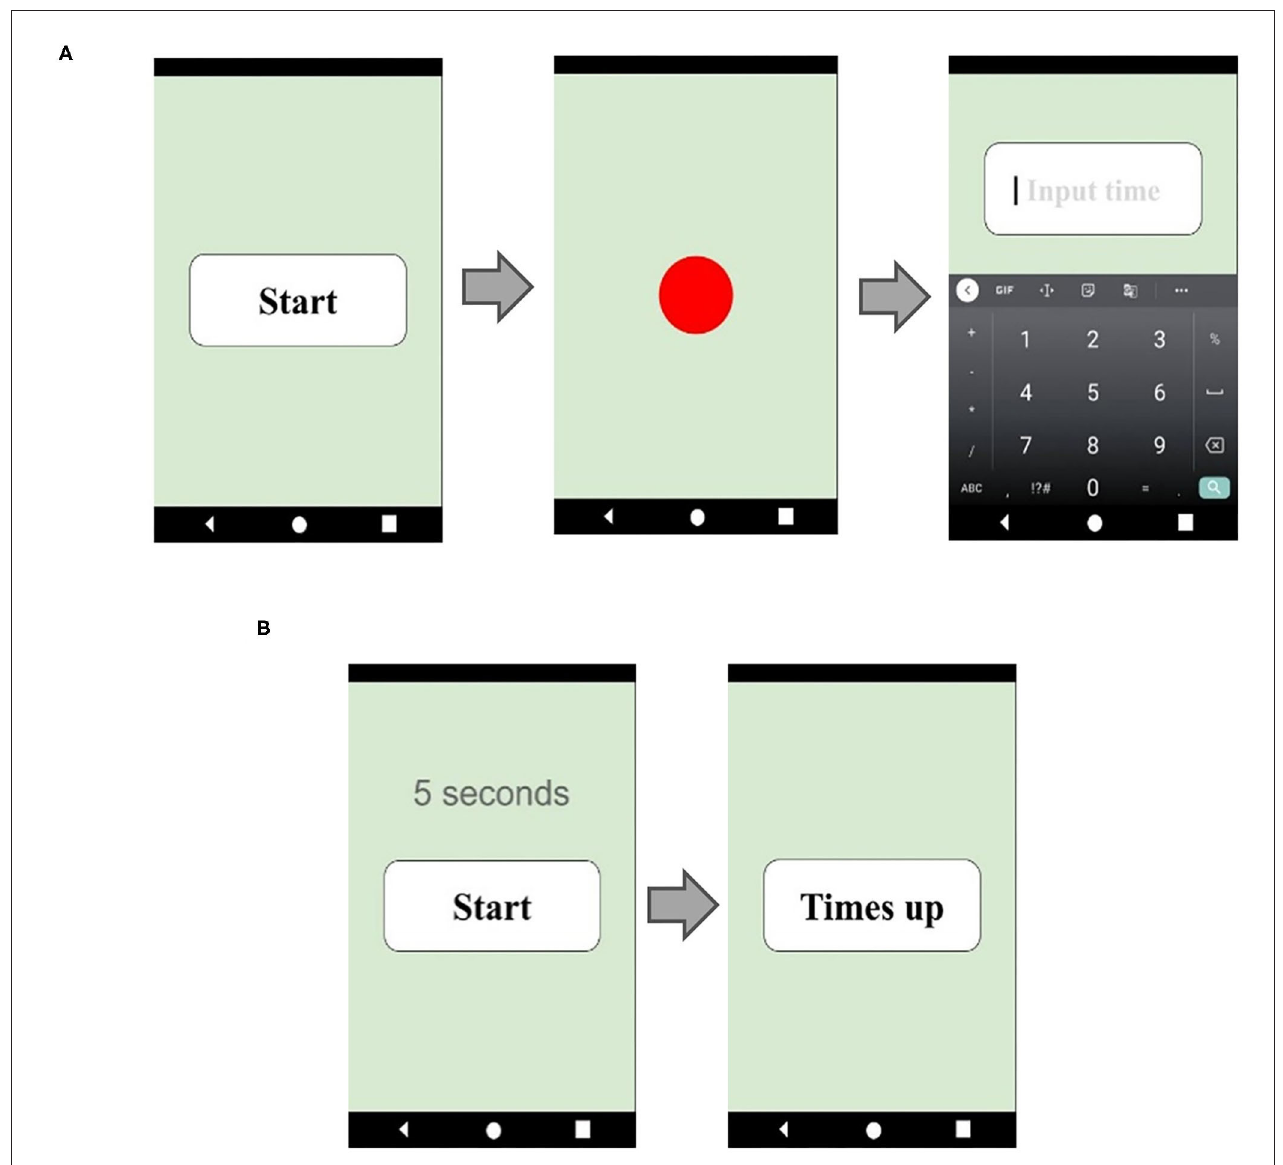
FIGURE 1 | (A) Verbal estimation test. (B) Time interval production test.